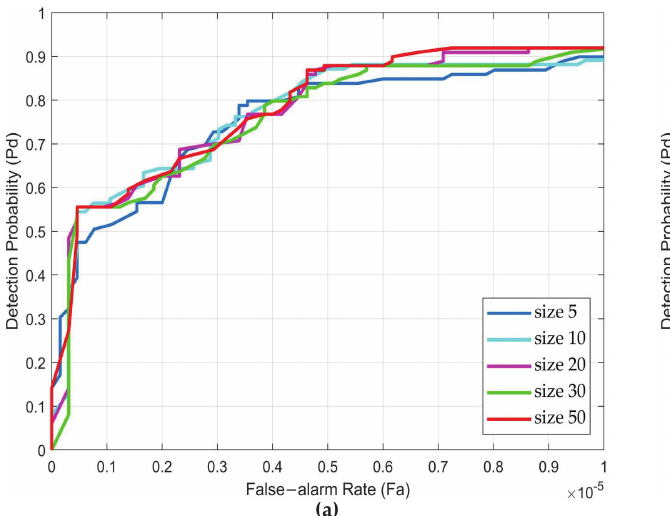
Figure 5. The representative images of the four real image sequences and the corresponding processed target images of different block sizes. From left to right are the original data and the processing results of size 5, size 10, size 20, size 30, and size 50.